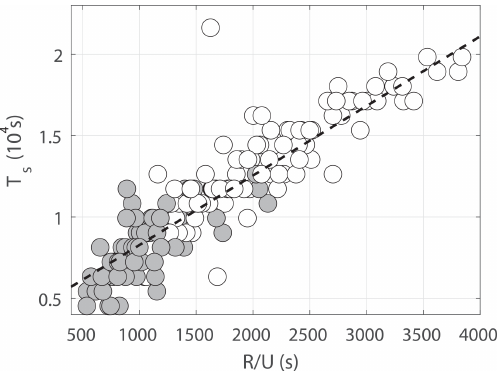
Figure 8. Separation time ( T s ) plotted against R/U . The dashed line is the best linear fit T s = 4 . 3 R/U + 3998. Straits with self- propagating dipoles are marked in gray.